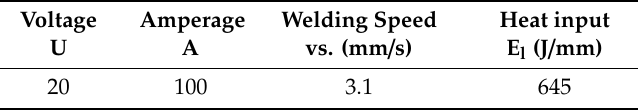
Table 6. Welding regime of the samples.